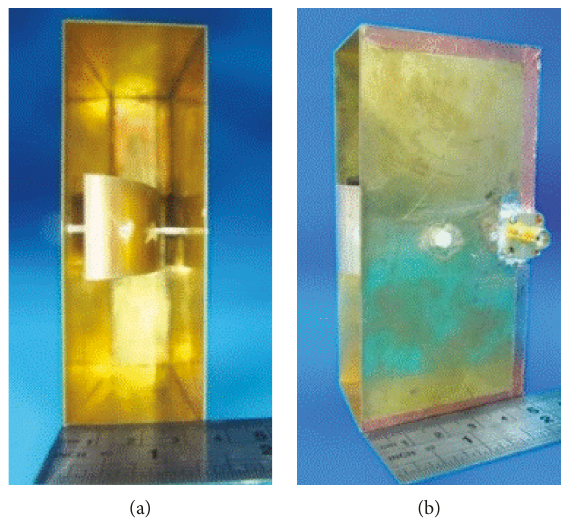
Figure 6: An archetype of the wideband HP quasi-omnidirectional antenna: (a) front view and (b) right-side view.